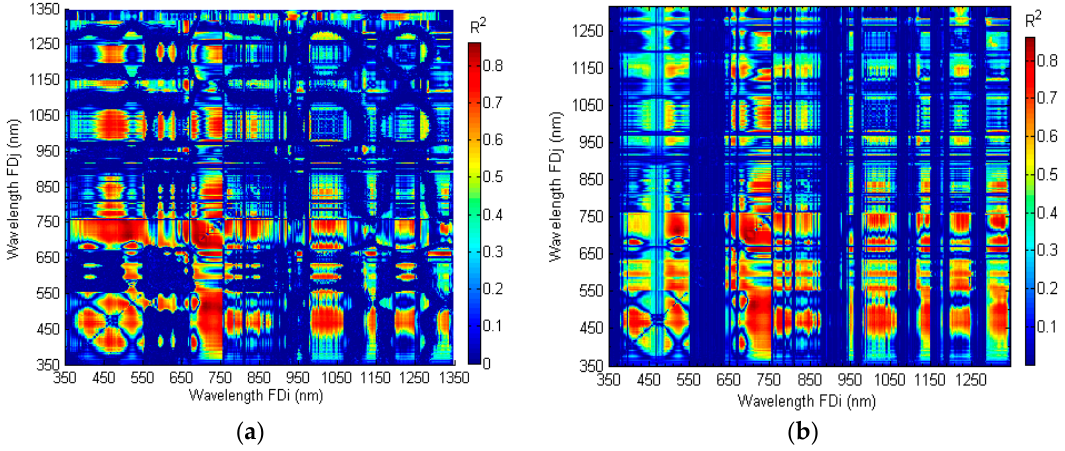
Figure 3. Image map of the coefficient of determination (R 2 ) between LNC and ( a ) FD-NDNI (i, j) ( b ) FD-SRNI (i, j) using the thorough combinations of two wavebands at i and j nm.